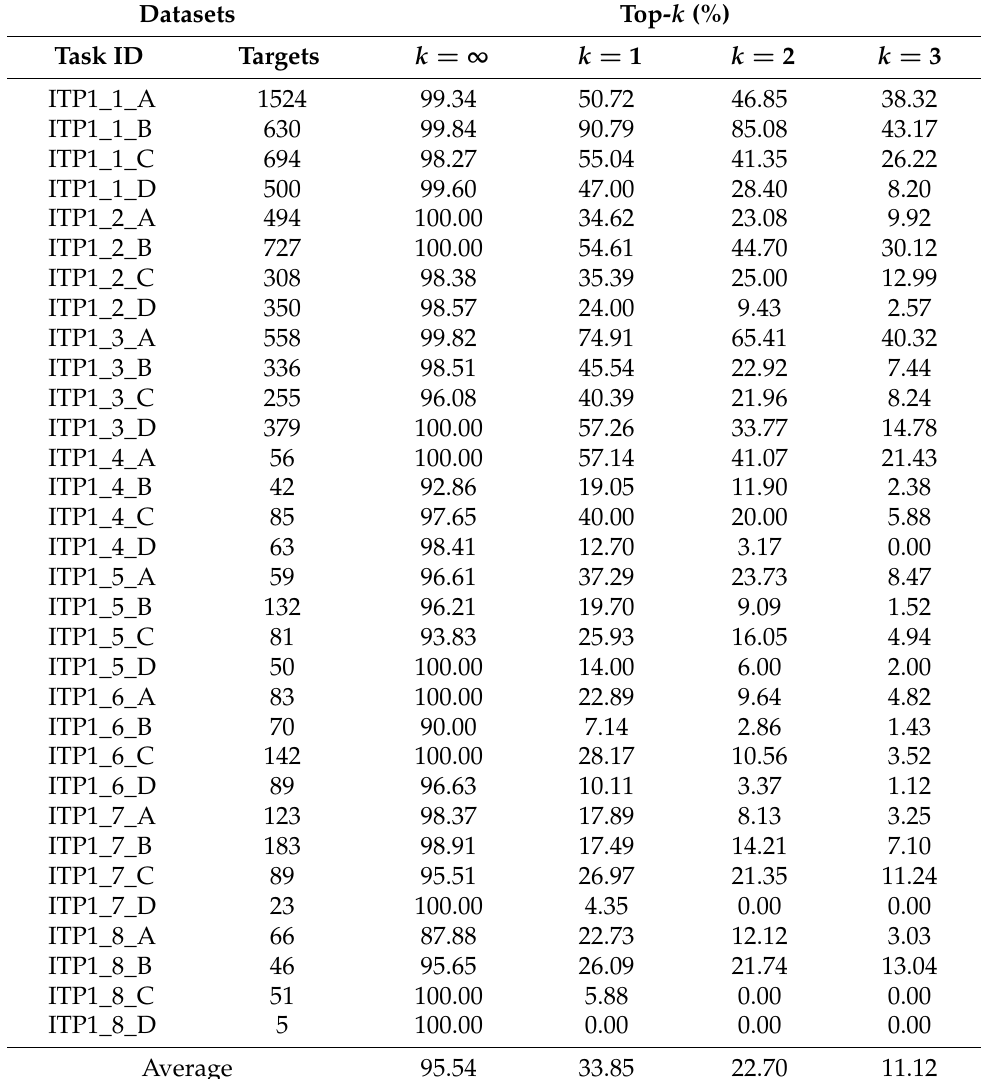
Table 8. Detection